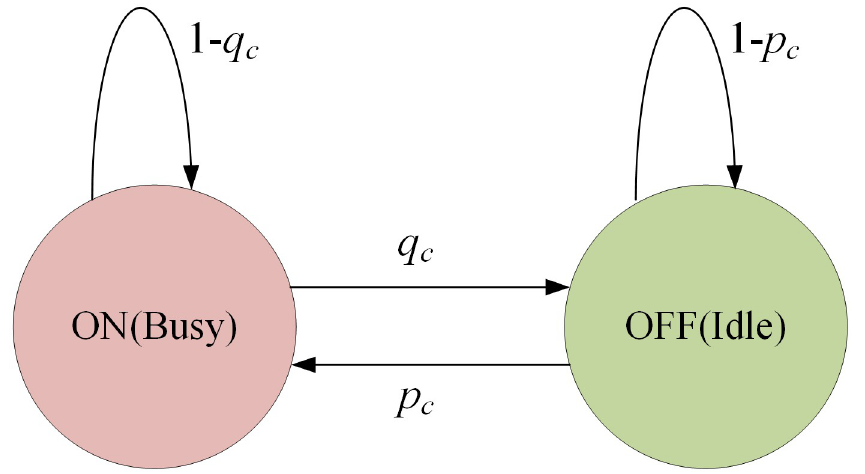
Fig 2. ON/OFF model for spectrum usage of